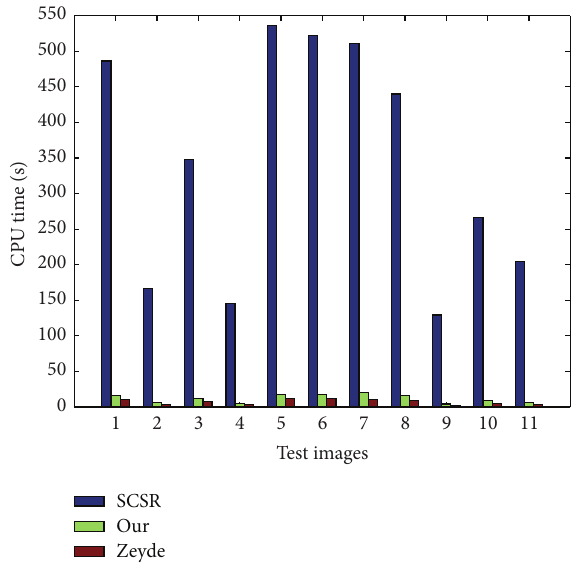
Figure 8: The CPU time comparison of our method with [11,